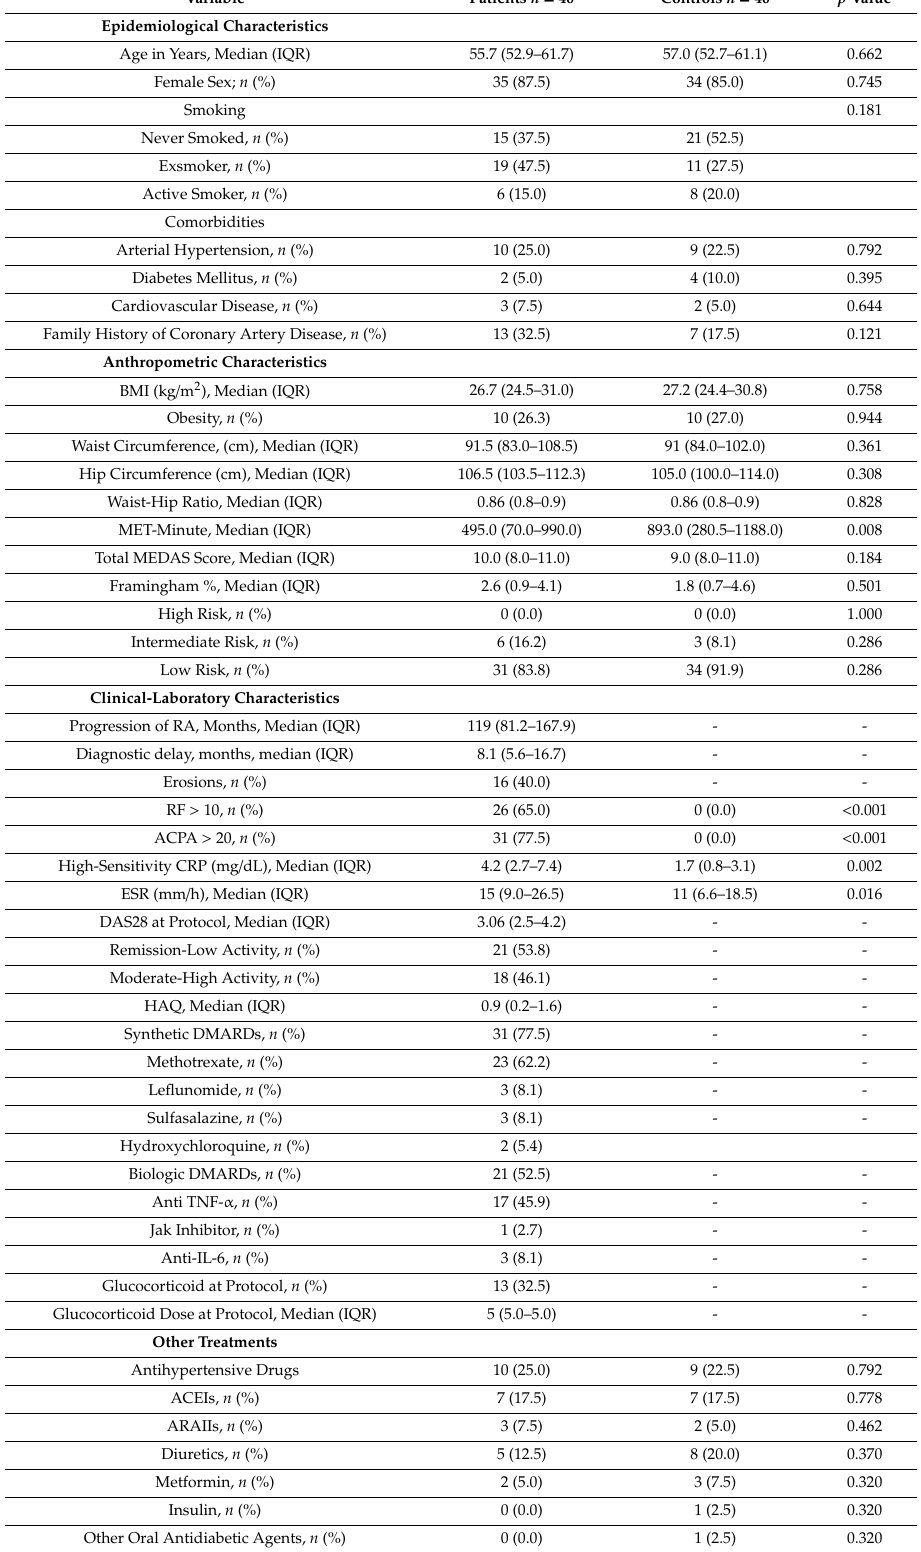
Table 1. Baseline characteristics of 40 patients with RA and 40